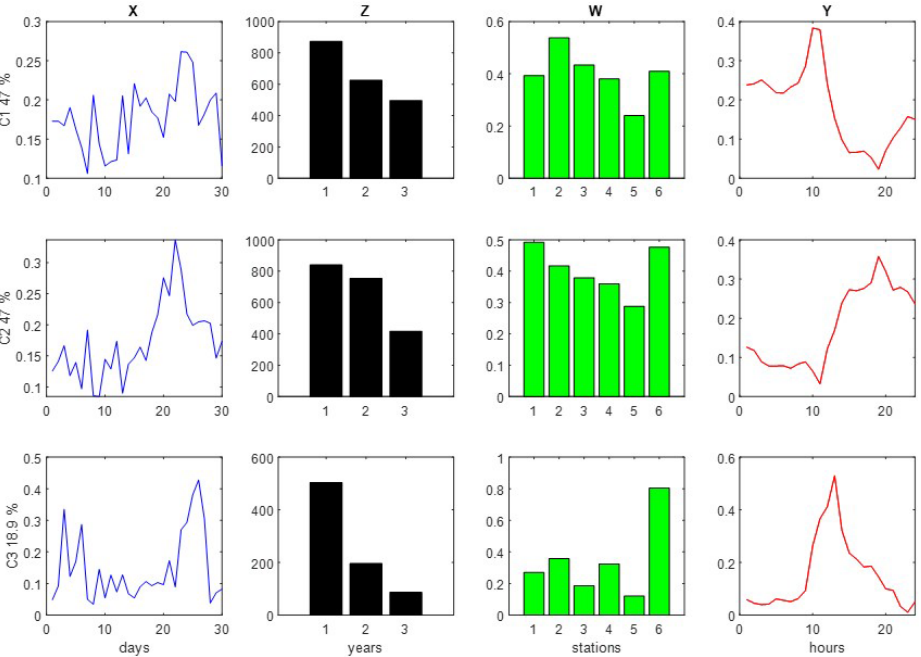
(Eq. 3) using non- 10